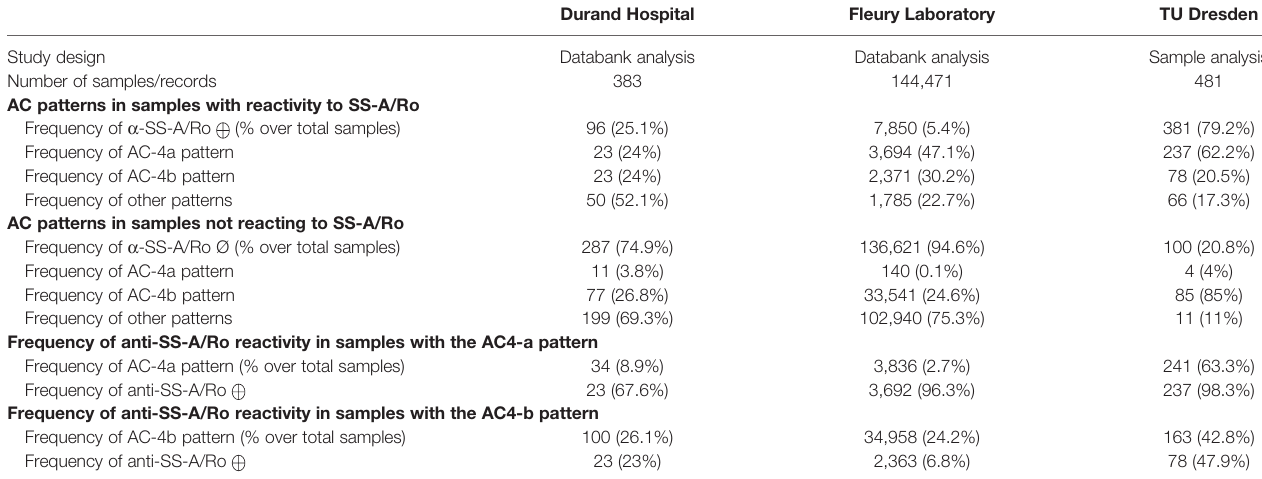
TABLE 2 | Summary of data on the association of AC-4a and AC-4b patterns with reactivity to SS-A/Ro in the three clinical